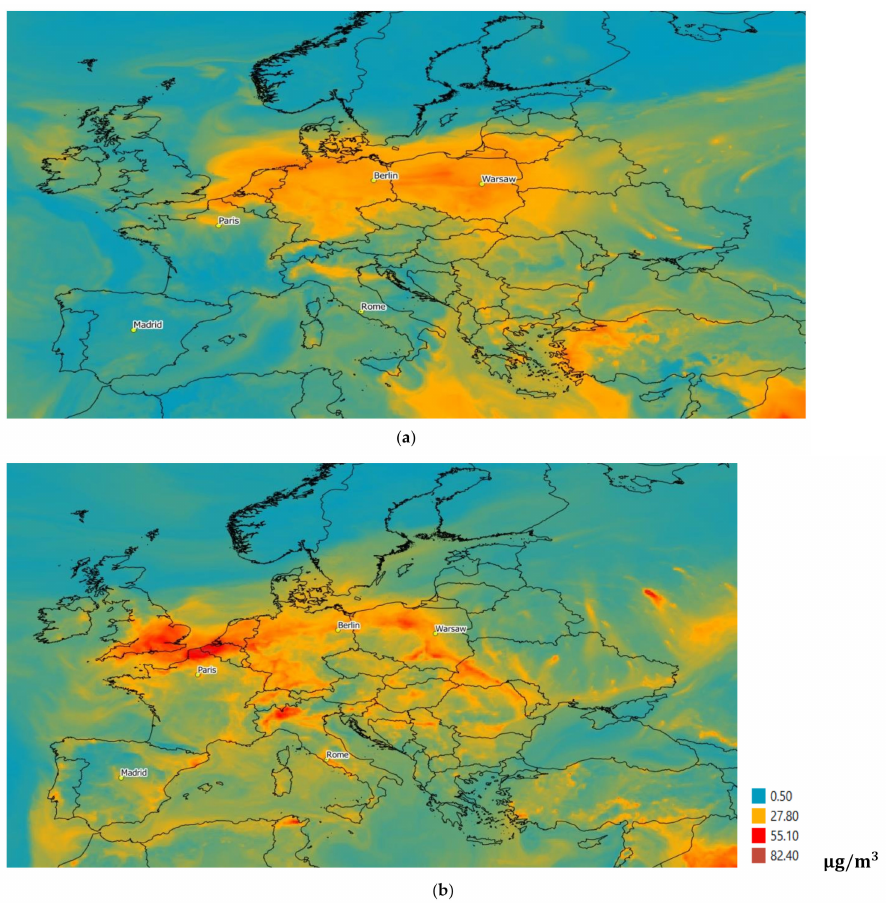
Figure 13. Thermal maps of PM 2.5 on ( a ) 04/10/2018 and ( b ) 04/10/2020. Source: Own elaboration, based on data from Copernicus Atmosphere Monitoring Service (CAMS) [47].